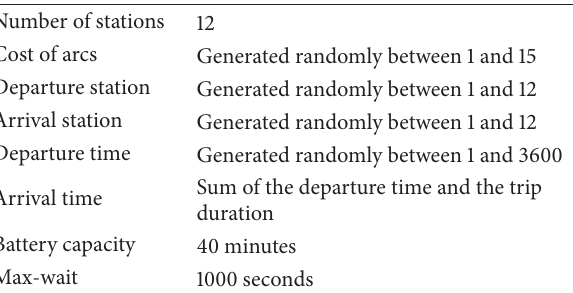
Figure 5: Illustration of optimal correction heuristic. Table 1: Instance assumptions.